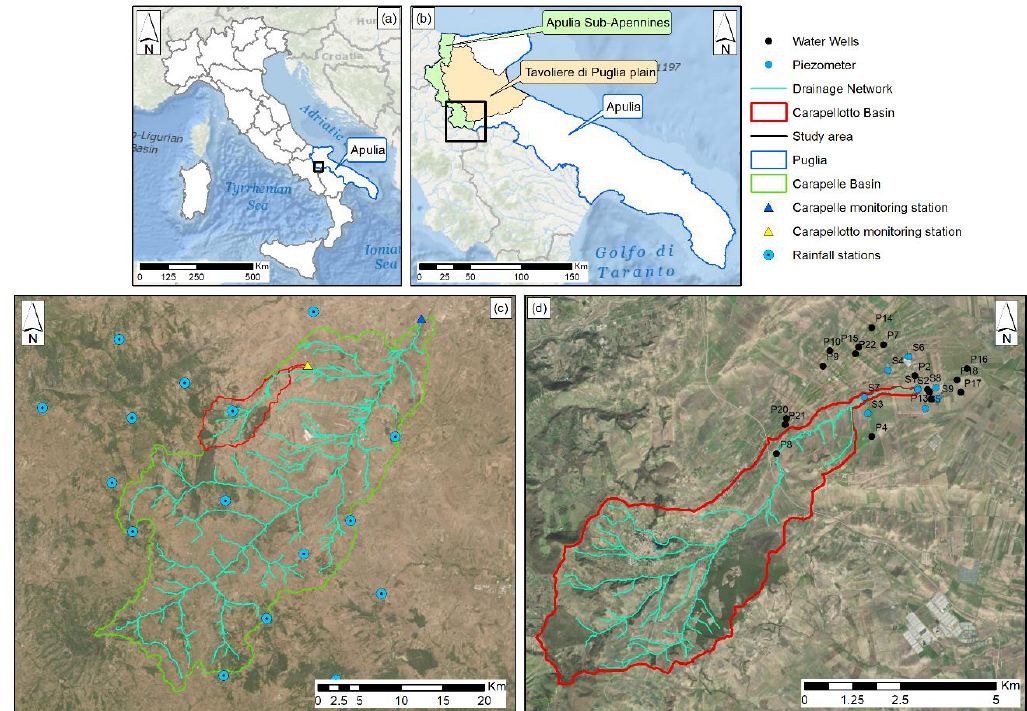
Figure 1. Study locations map: ( a ) Apulia region (Southern Italy) and study area; ( b ) Study area, Apulia Sub-Apennines and Tavoliere di Puglia; ( c ) Carapelle and Carapellotto basins; Carapelle and Carapellotto monitoring stations; drainage network and rainfall measurement stations; ( d ) Carapellotto basin; drainage network, piezometers and water wells for groundwater monitoring.